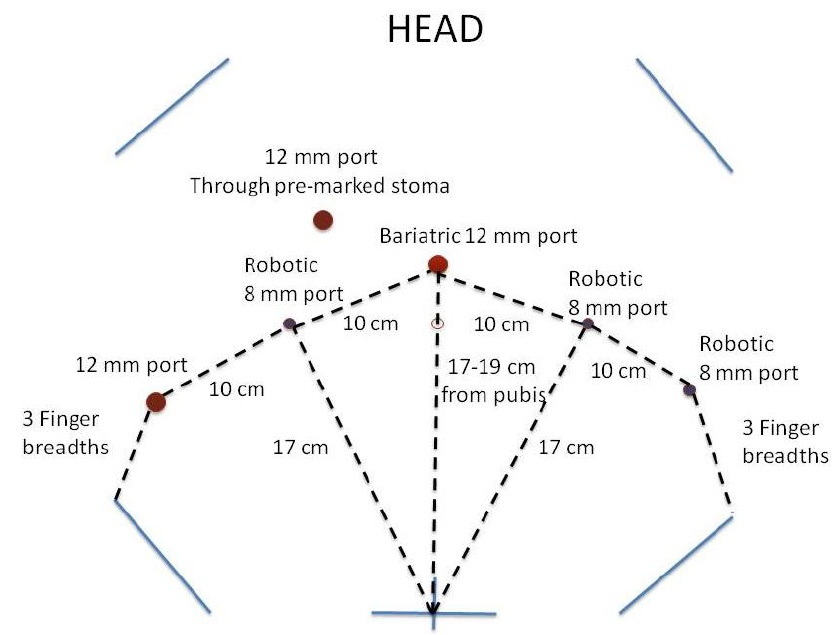
FIGURE 1. Port placement for the da Vinci S